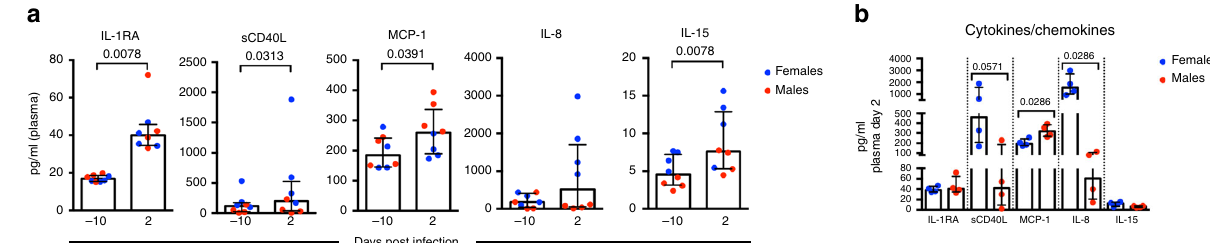
Fig. 3 Induction of pro-in fl ammatory cytokines following ZIKV infection. a Concentrations (pg ml − 1 ) of plasma IL-1RA, sCD40L, MCP-1, IL-8, and IL-15 at baseline ( − 10 dpi) and 2 dpi were measured by Luminex. Blue (females) and red (males) symbols indicate individual animals ( n = 8). Medians are indicated by bars with interquartile ranges. Differences between responses at baseline and 2 dpi were evaluated using paired Wilcoxon tests ( n = 8), with unadjusted p -values displayed and signi fi cant differences de fi ned as p ≤ 0.05. b Concentrations (pg ml − 1 ) of plasma cytokines and chemokines at 2 dpi were measured by Luminex. Symbols indicate individual animals ( n = 8), females (blue) or males (red). Medians are indicated by bars and show interquartile ranges. Differences between males and females were evaluated using Wilcoxon tests ( n = 4 per group), and the corresponding unadjusted signi fi cant ( p ≤ 0.05) or trending ( p ≤ 0.08) p -values are shown